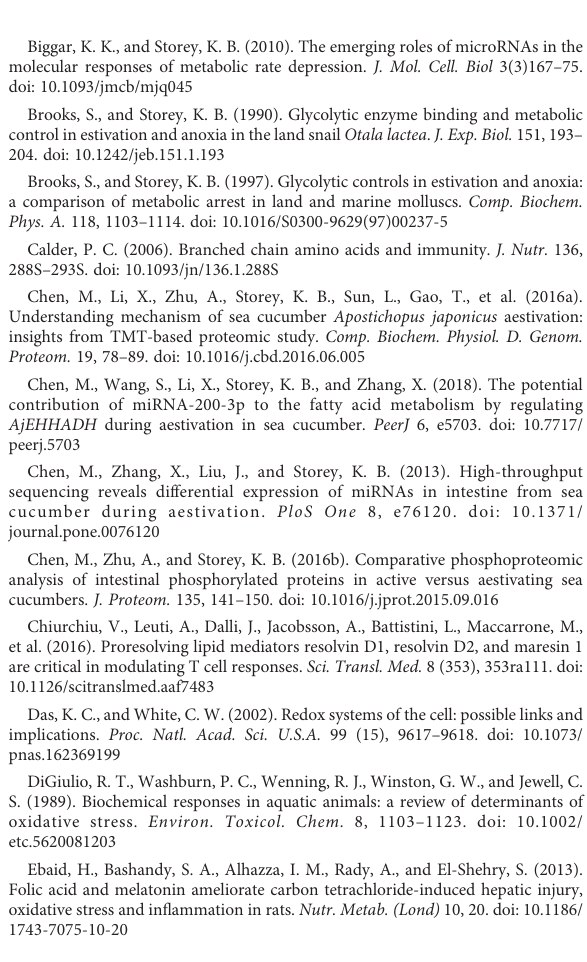
SUPPLEMENTARY FIGURE 1 The intestine tissue of A. japonicus during estivation cycles. (A) NA stage, (B) DA stage, (C) AA stage.